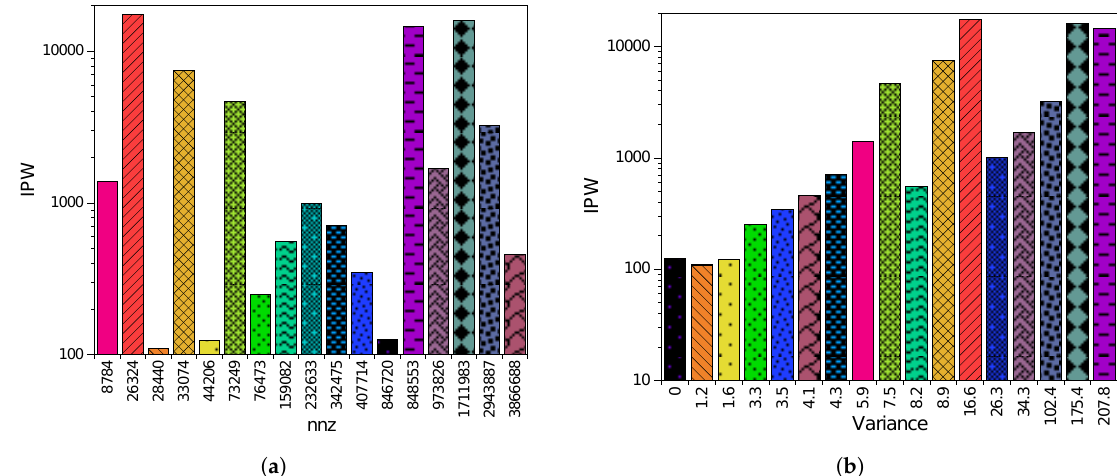
Figure 9. ELL instructions per warp (IPW) against: ( a ) nnz and ( b ) npr variance .